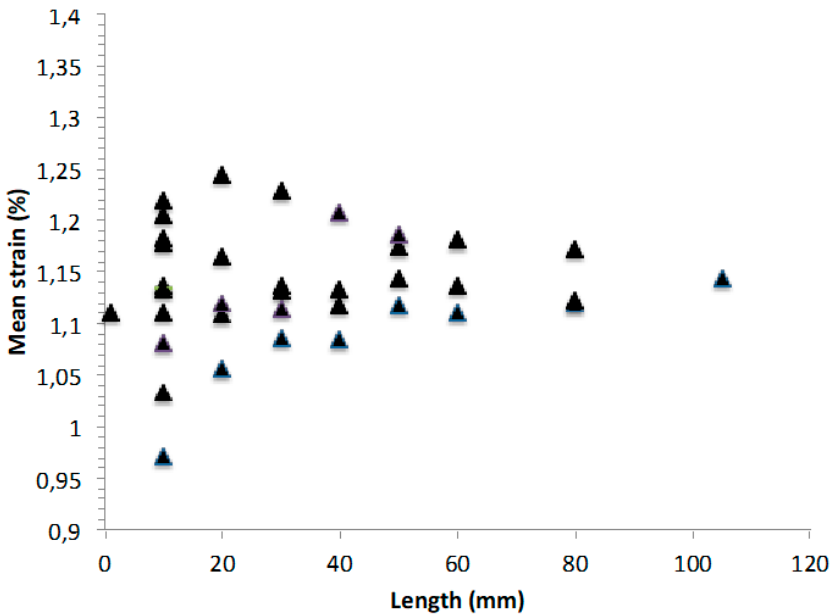
Figure 16. Variation in mean strain value with segment length.